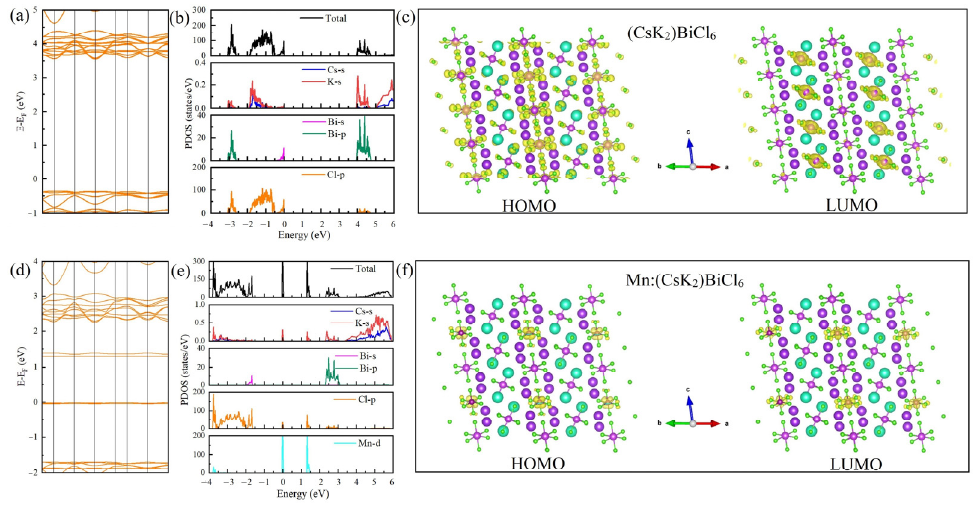
Figure 3. Calculated band structures ( a , d ), density of states ( b , e ), and charge densities ( c , f ) of Mn-doped and undoped (CsK 2 )BiCl 6 .